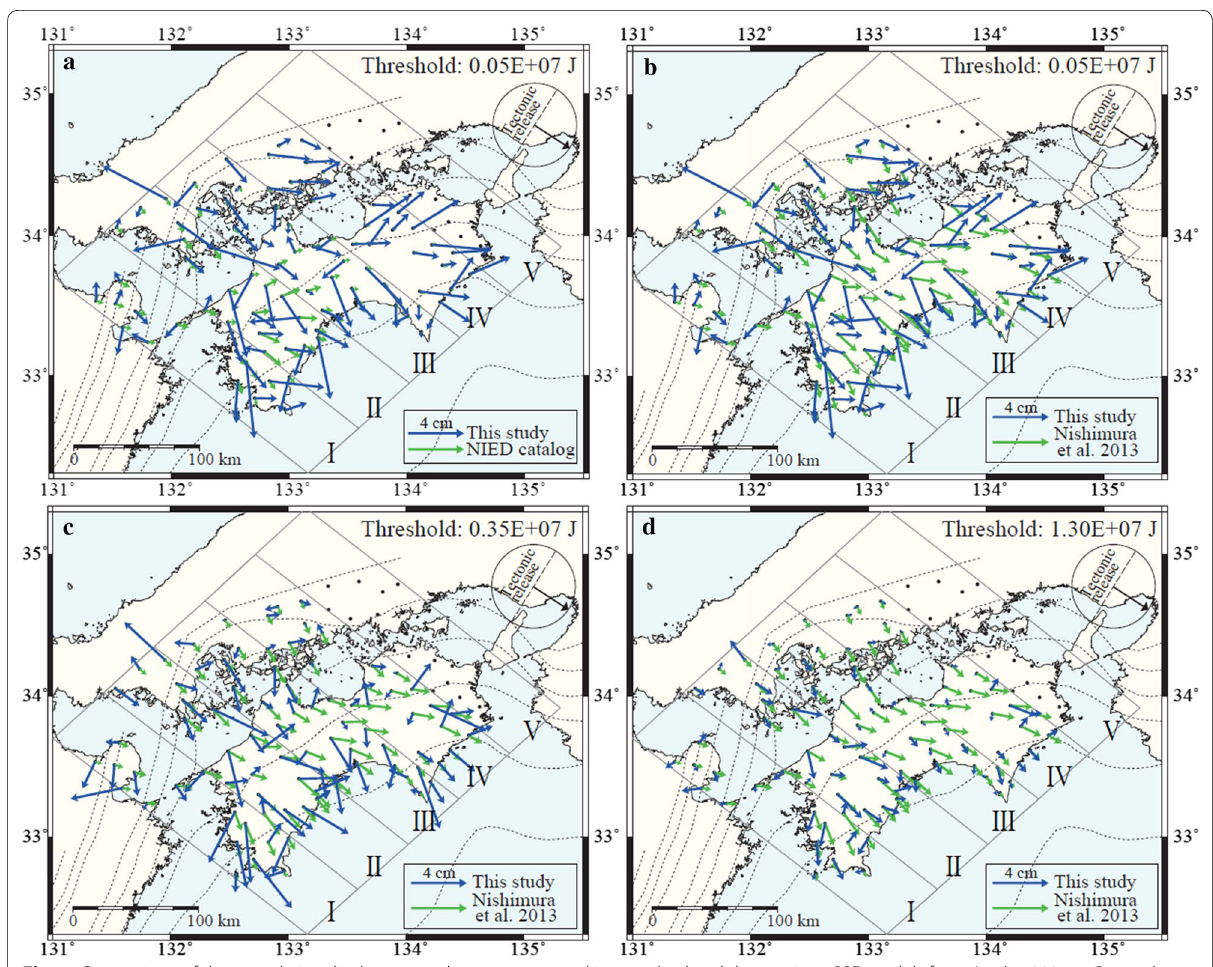
Fig. 5 Comparison of the cumulative displacements between our stacking method and the previous SSE models from April 1, 2004 to December 31, 2009. Blue and green arrows indicate the cumulative displacements obtained in our analysis and those calculated from the previous SSE models, respectively. a Model of the NIED catalog with a tremor energy threshold of 0.05 × 10 7 J . b Same as a , but with the models of Nishimura et al. (2013). c Same as b , but with a tremor energy threshold of 0.35 × 10 7 J . d Same as b , but with a tremor energy threshold of 1.30 × 10 7